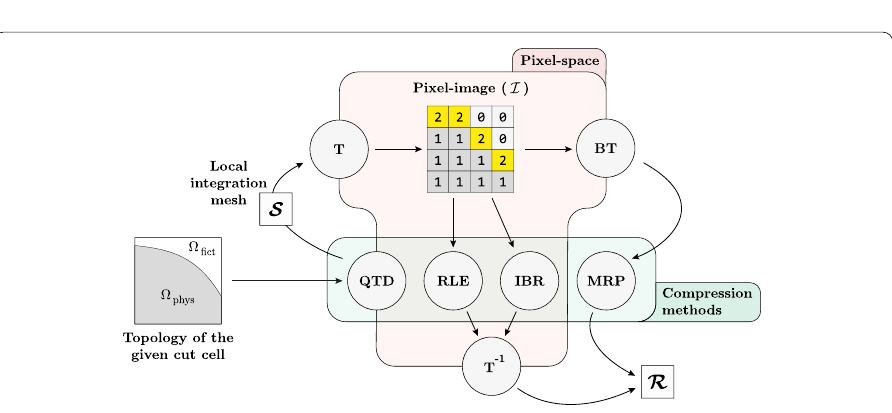
Fig. 10 QTD of a cut cell and corresponding pixel-image. The pixel values 0, 1 and 2 denote physical, fictitious and cut sub-cells, respectively. The image consist of 2 k × 2 k pixels, where k is the refinement level of the QTD ( k = 5)